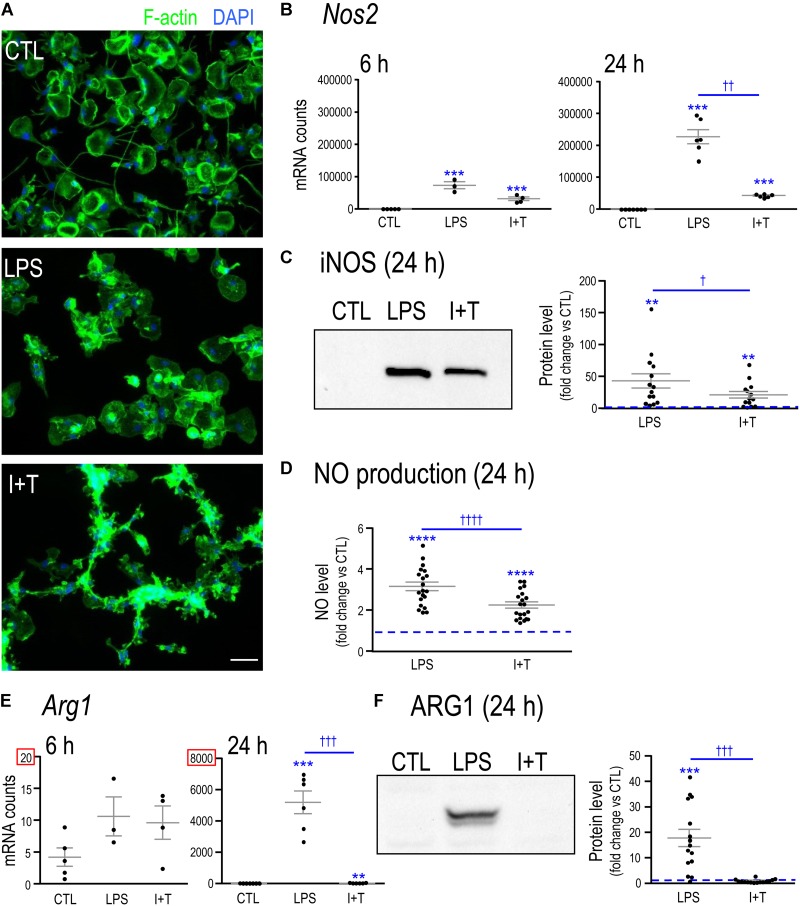
Verifying that primary rat microglia responded to LPS and to IFNγ+TNFα. (A) Representative fluorescence images of primary rat microglia (unstimulated, CTL) after 24 h treatment with LPS or a combination of IFNγ + TNFα (I+T). Fixed microglia were stained for F actin (phalloidin; green) and nuclei were labeled with DAPI (blue). Scale bar, 50 μm. (B)
Nos2 mRNA levels were measured by Nanostring and are expressed as mRNA counts/200 ng RNA sample (6 h: 3–5 individual cultures; 24 h: 6–7 individual cultures). (C) iNOS protein levels at 24 h. Left: Representative Western blot. Blots were analyzed and normalized to total Coomassie blue staining. Right: Fold-changes with respect to controls (dashed line) were plotted for separate replicates from different cultures (14 individual cultures). (D) Cumulative nitric oxide (NO) production for the 24 h period after stimulation (20 individual cultures). (E)
Arg1 mRNA levels were measured and analyzed as in Panel B. (F) Arg1 protein levels at 24 h. Western blots were analyzed as in Panel C (15 individual cultures). For all graphs, values are plotted as mean ± SEM, and differences are indicated with respect to control microglia (∗) and between stimuli (†). One symbol of either type indicates p < 0.05; two symbols, p < 0.01; three symbols, p < 0.001; four symbols, p < 0.0001.